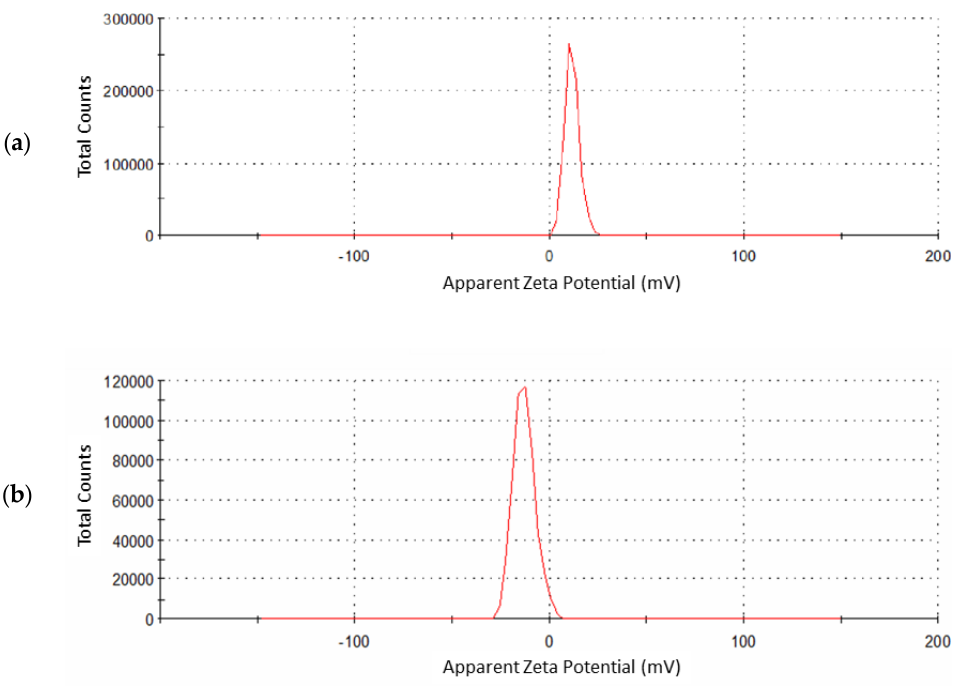
Figure 6. Zeta potential measurement for ( a ) Fe 3 O 4 and ( b ) Fe 3 O 4 @SiO 2 @APTES.